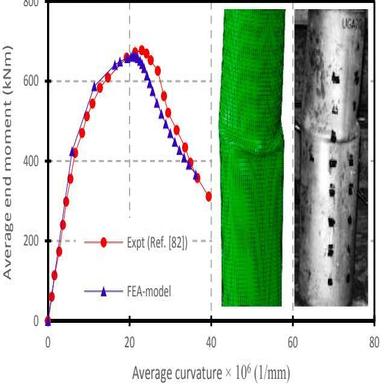
Comparison of FEA result with experimental result (UGA508) by Ref. .